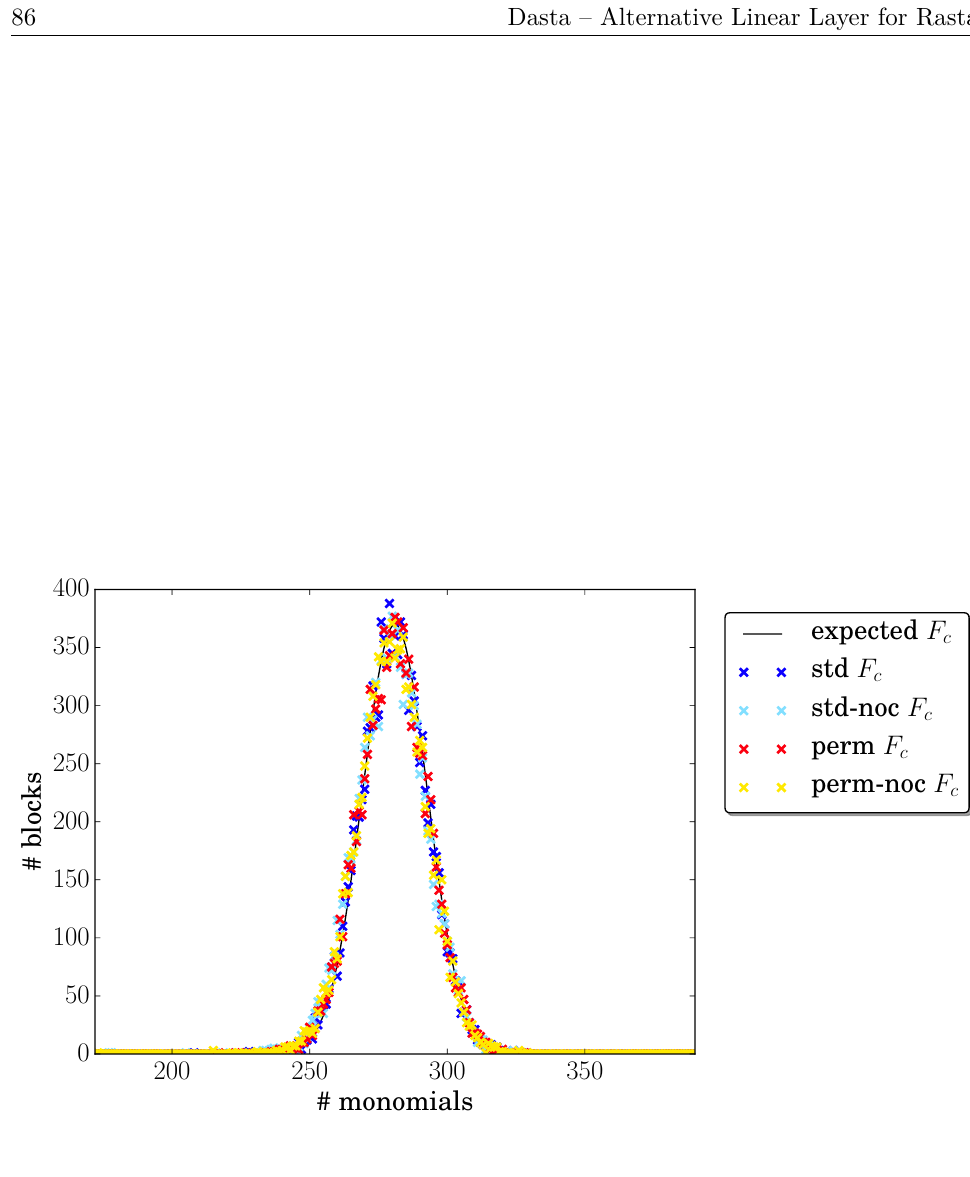
Figure 9: Distribution of monomial count for | B | = 11000 and 2